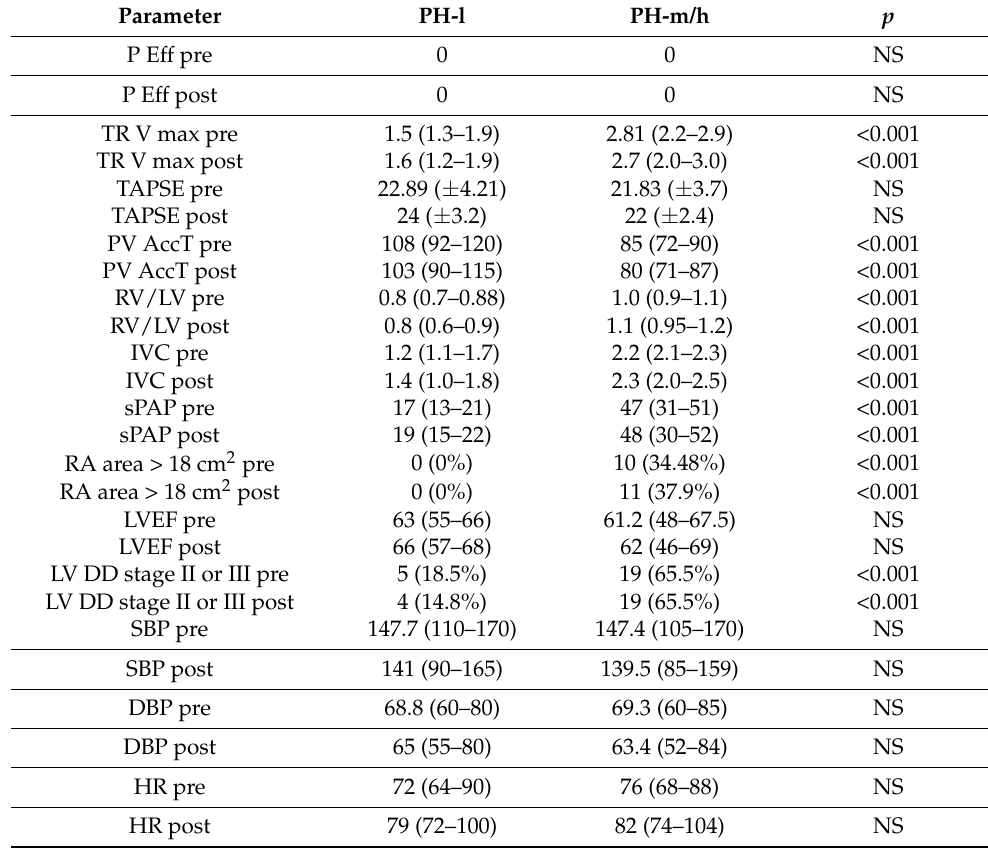
Table 4. Echocardiographic parameters, arterial blood pressure, heart rate, and occurrence of left ventricular diastolic dysfunction before and after CABG.